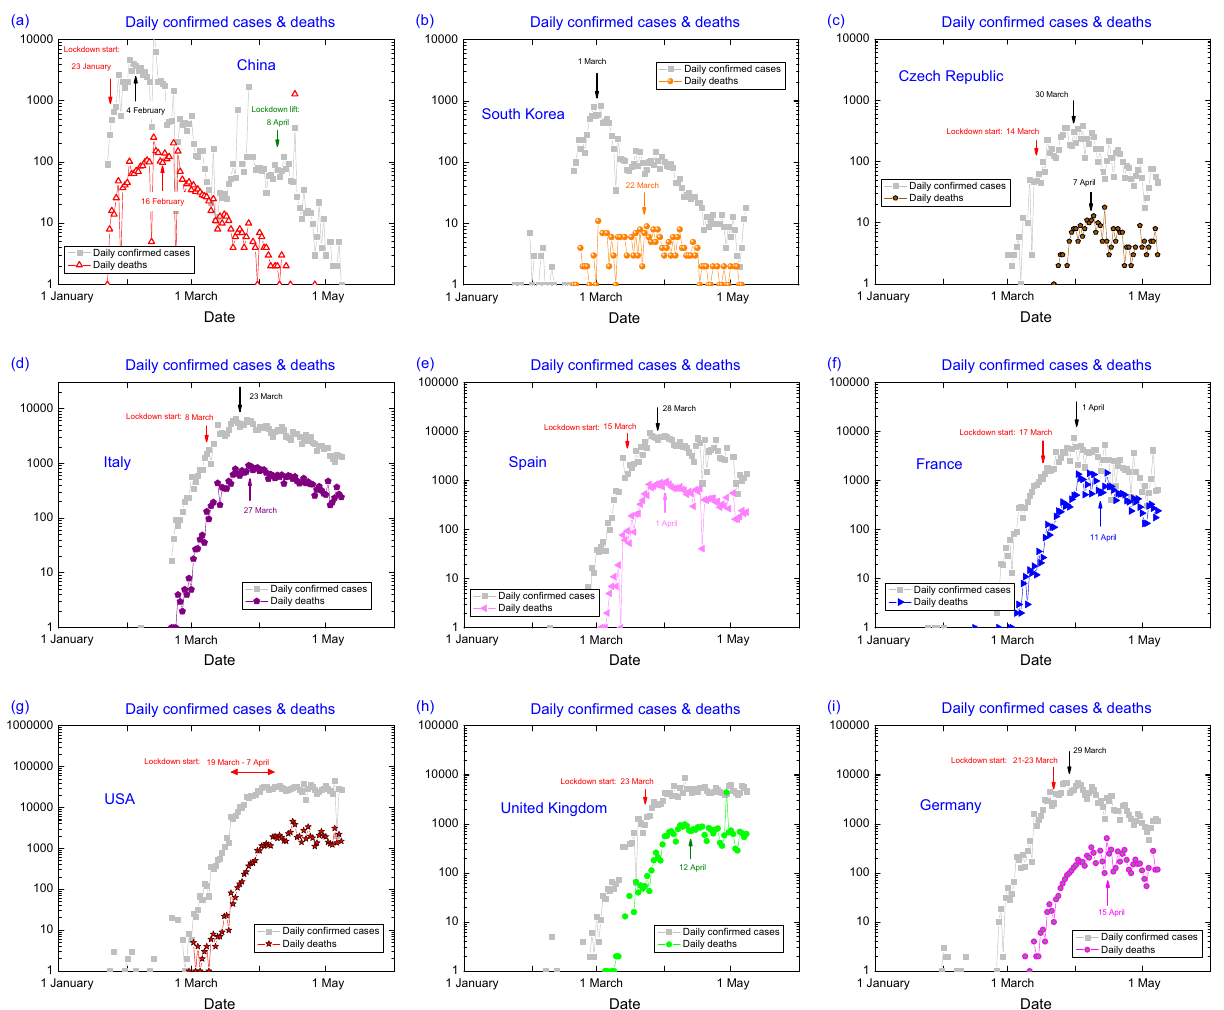
Figure 2. Time variation of daily con fi rmed cases and deaths in a selection of nine countries: (a) China, (b) South Korea, (c) Czech Republic, (d) Italy, (e) Spain, (f) France, (g) USA, (h) UK, and (i) Germany [27 –